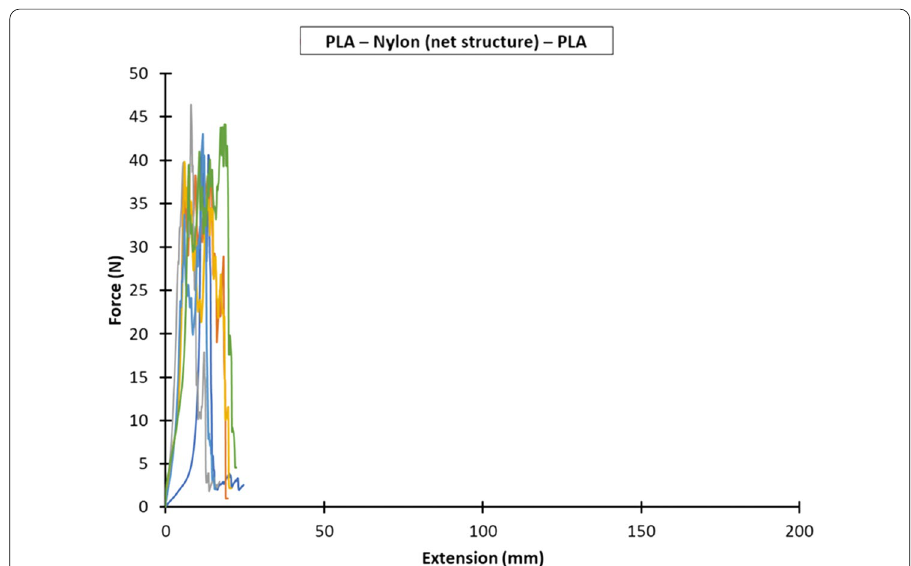
Fig. 7 Force versus extension plots for six specimens with the PLA—Nylon (net structure)—PLA orientation